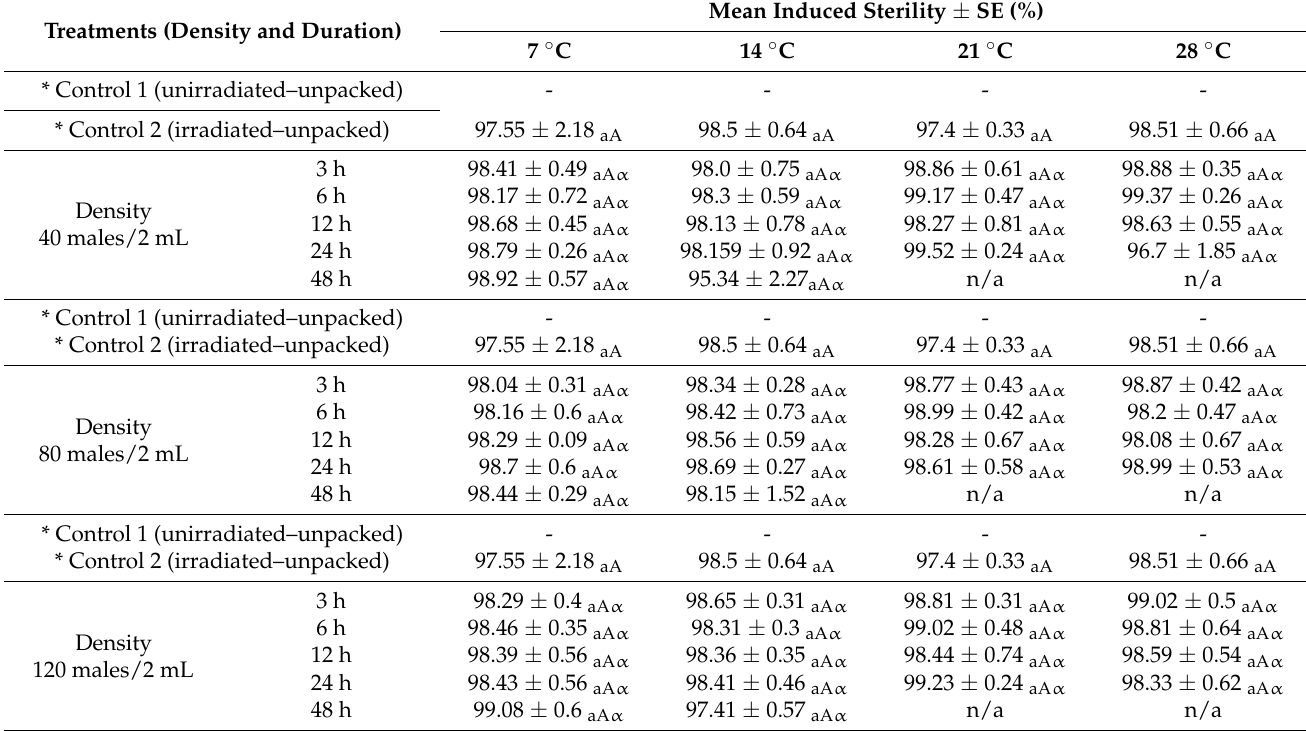
Table 4. Mean induced sterility of gamma-sterilized male Ae. aegypti post-treatment by density, temperature, and duration